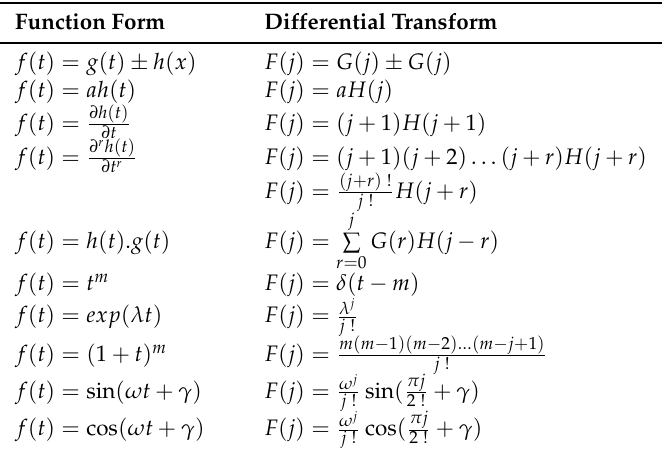
Table 3. The functions and their differential